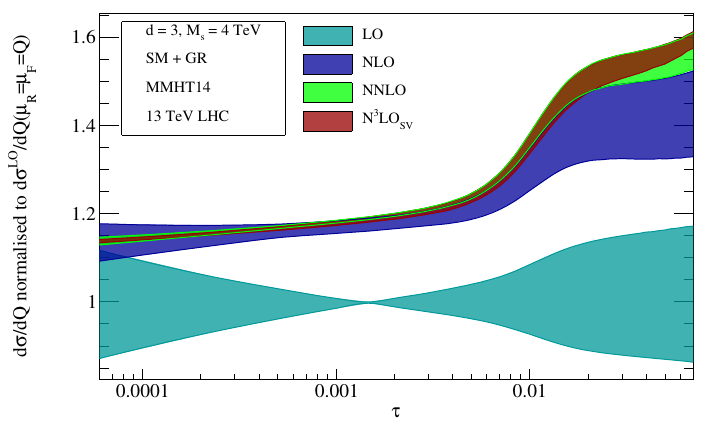
Figure 5 . Seven point scale variation is shown up to N 3 LO sv for invariant mass distribution of di-lepton pair at 13 TeV LHC. The ADD parameters are chosen as M S = 4 and d = 3. All the plots are normalized with LO contribution taken at (cid:22) r = (cid:22) f = Q and order-by-order PDF (see